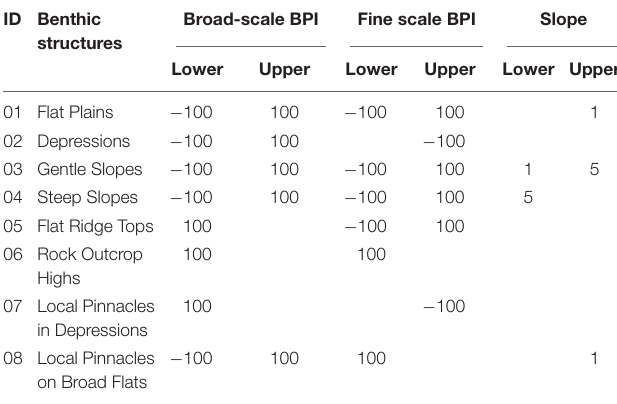
TABLE 1 | Decision table summarizing the factors used for the definition of benthic structures in the study area. ID Benthic